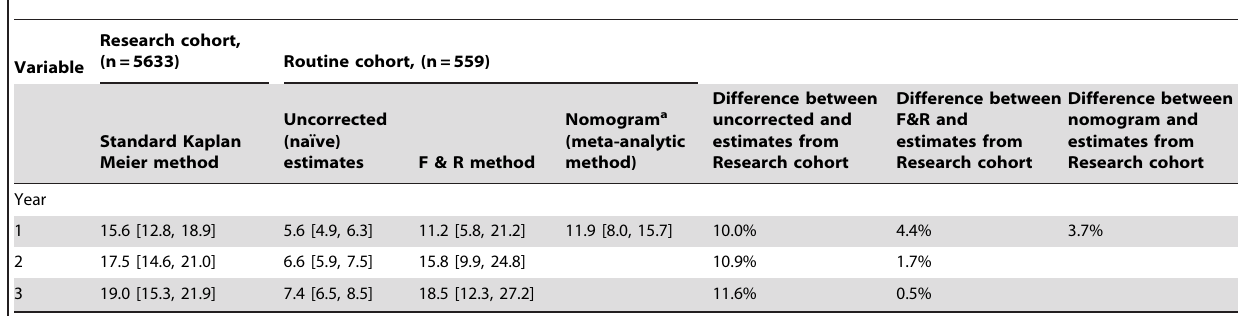
Table 3. Comparison on methods for correcting mortality in the Research and Routine cohorts.